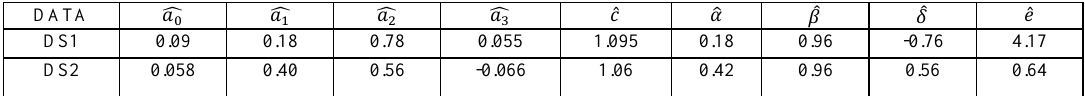
Table 2. The result of parameter estimation (bivariate CES Weibull model)